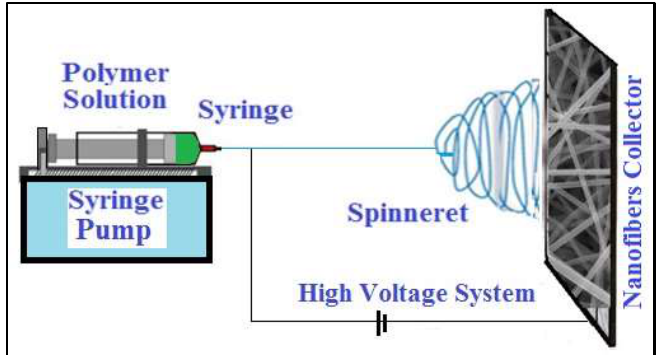
Figure 2: Schematic diagram of the electrospinning apparatus. Table 1. The operating parameters for the nanofilters synthesis processes.